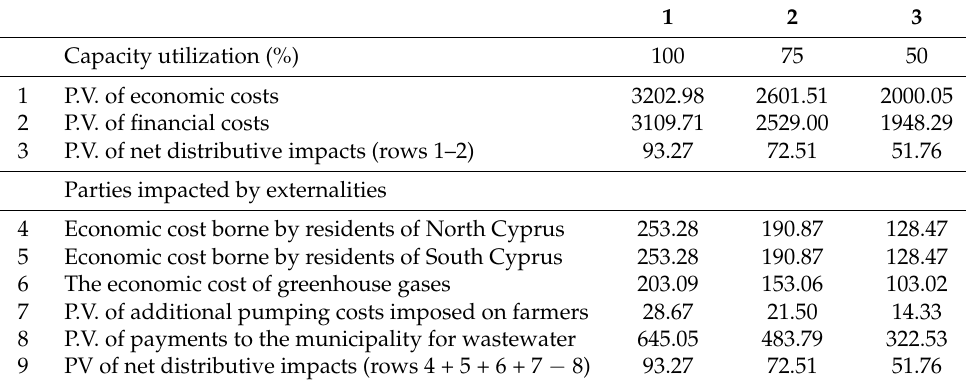
Table 8. Distributive Impacts of Different Levels of Utilization in 2022 Prices, ’000